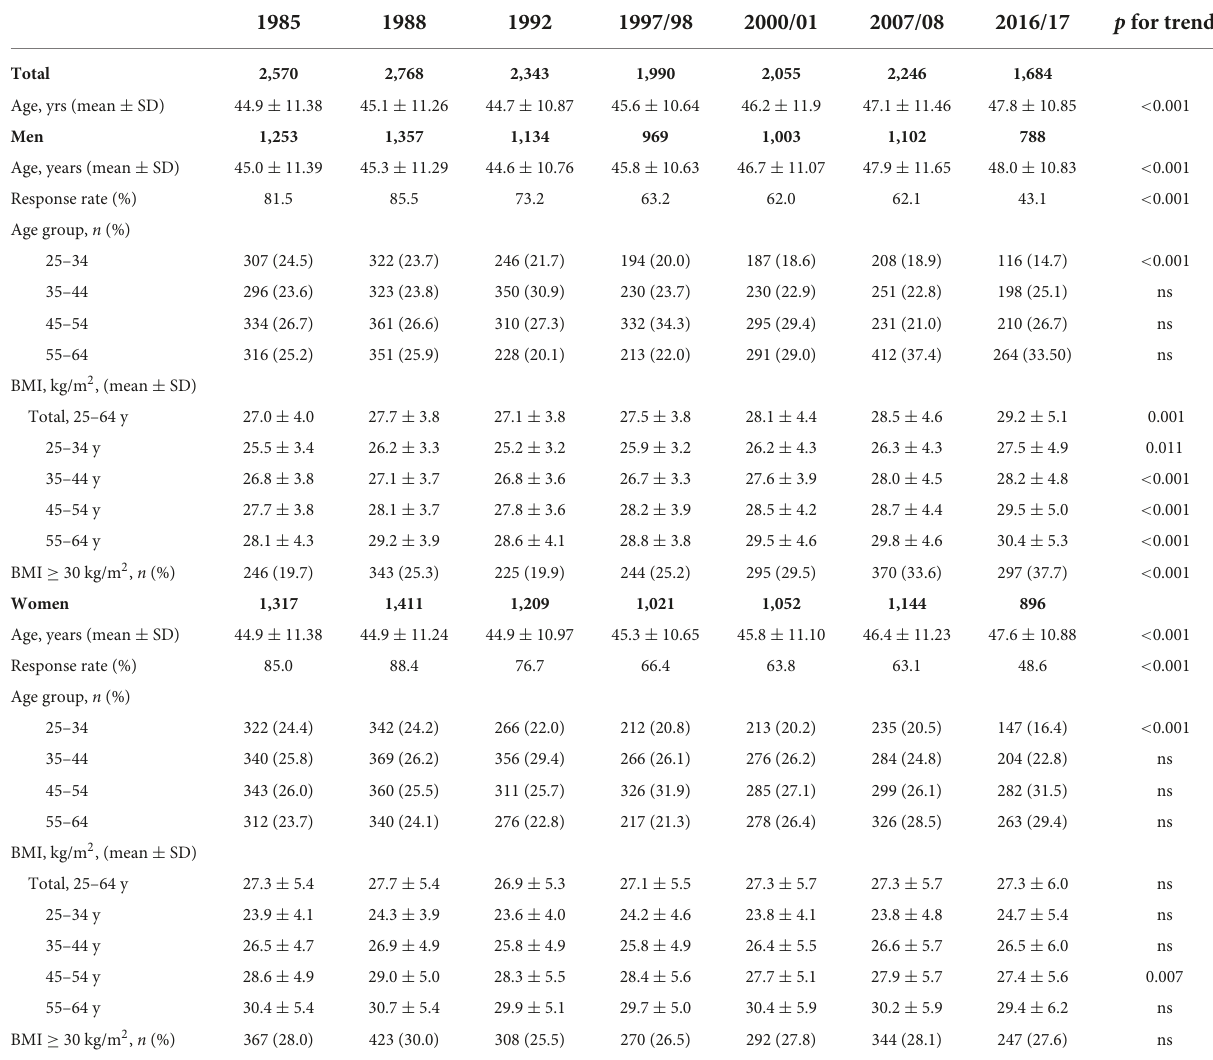
TABLE 1 Survey sample sizes, response rates, BMI, and obesity prevalence by sex and year of